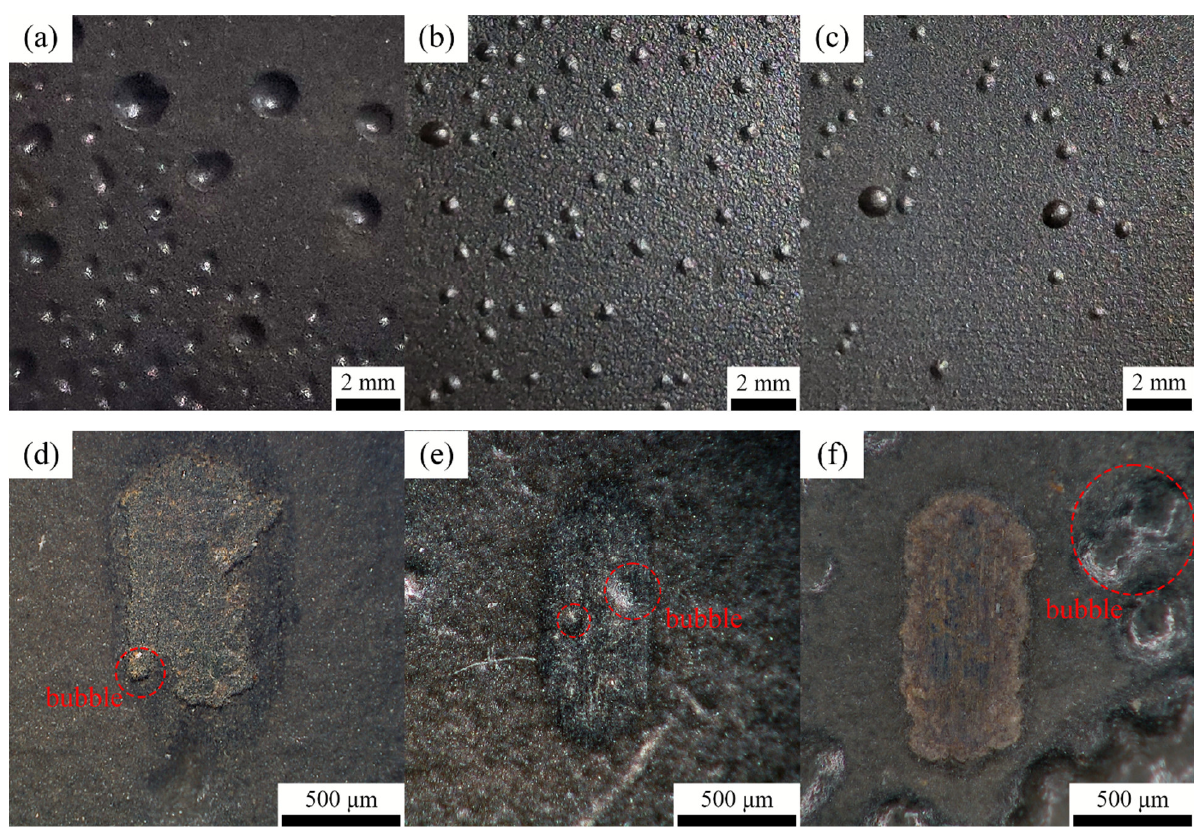
Figure 12. The surface of the coating after 18 days immersed in seawater. ( a ) T1.5 coating; ( b ) T2 coating; ( c ) T2.5 coating; ( d ) T1.5 wear marks; ( e ) T2 wear marks; ( f ) T2.5 wear marks.